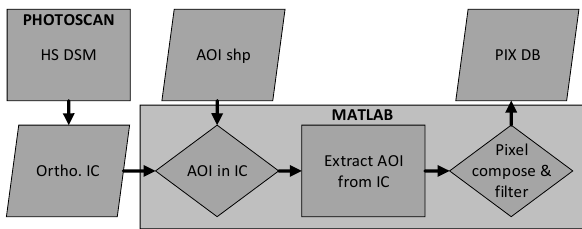
Figure 1 Pixel database (PIX DB) generation for an area of interest (AOI) from orthorectrified image cubes (ortho